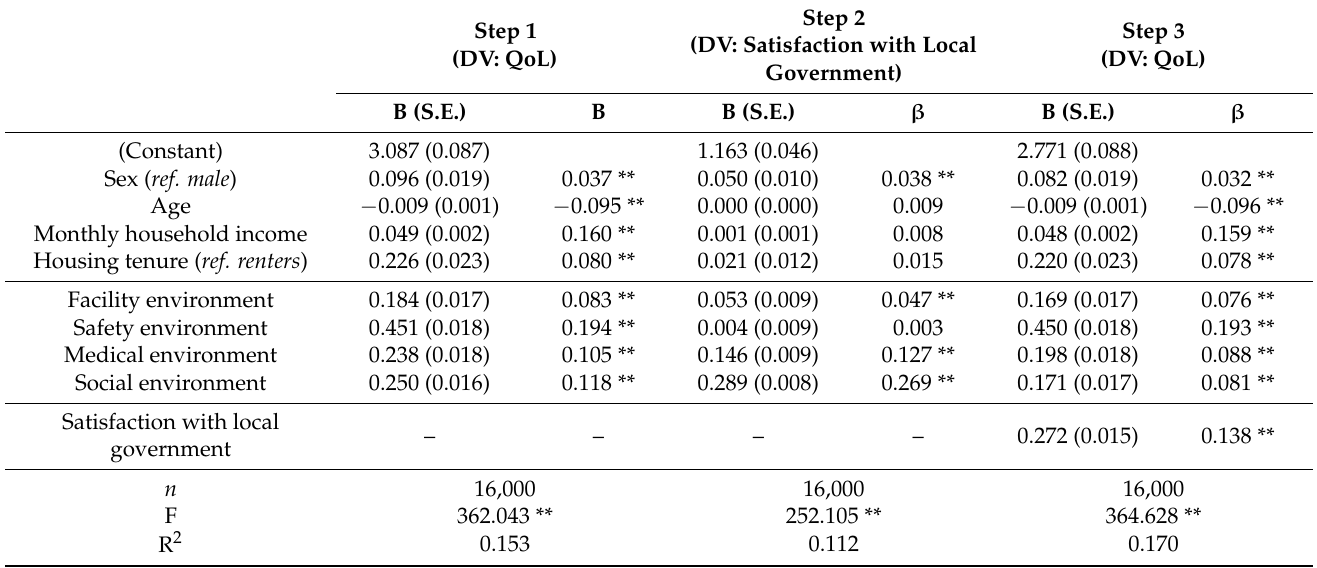
Table 5. Mediating effect analysis.